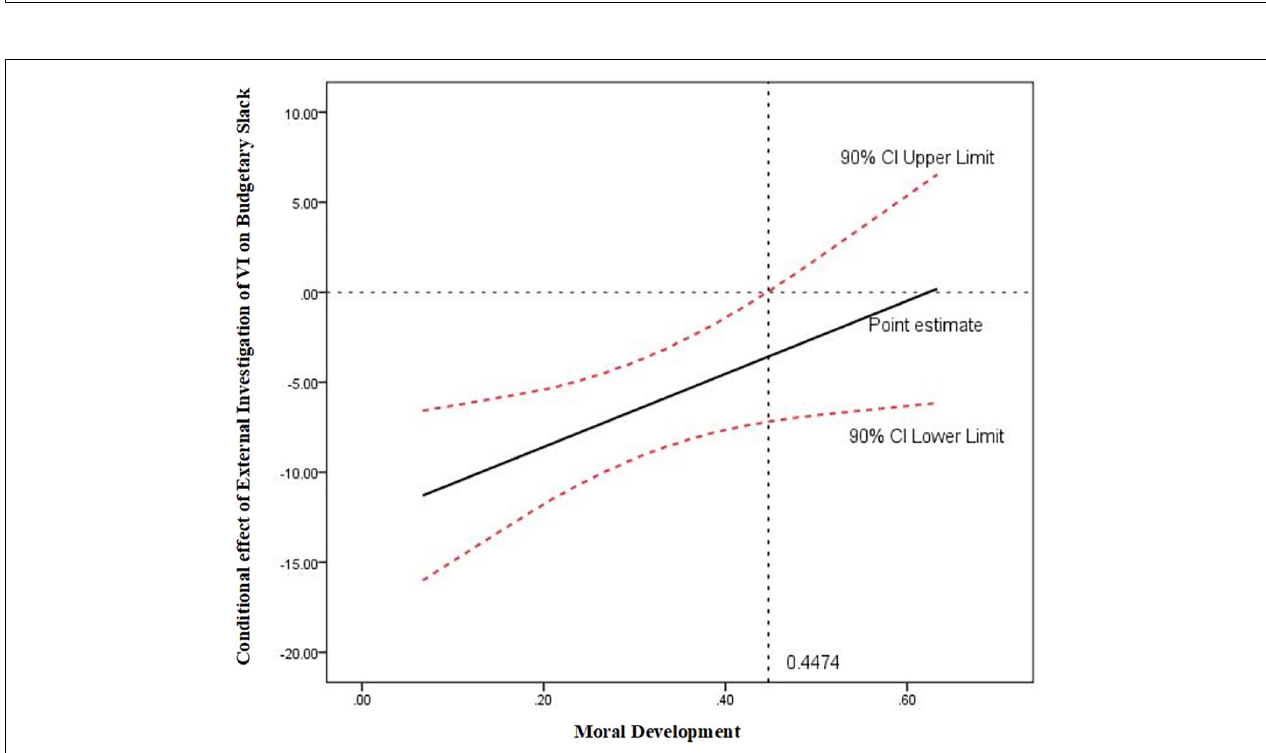
FIGURE 4 | Johnson–Neyman regions of significance for the conditional effect of external investigation of VI on budgetary slack at values of moral development.